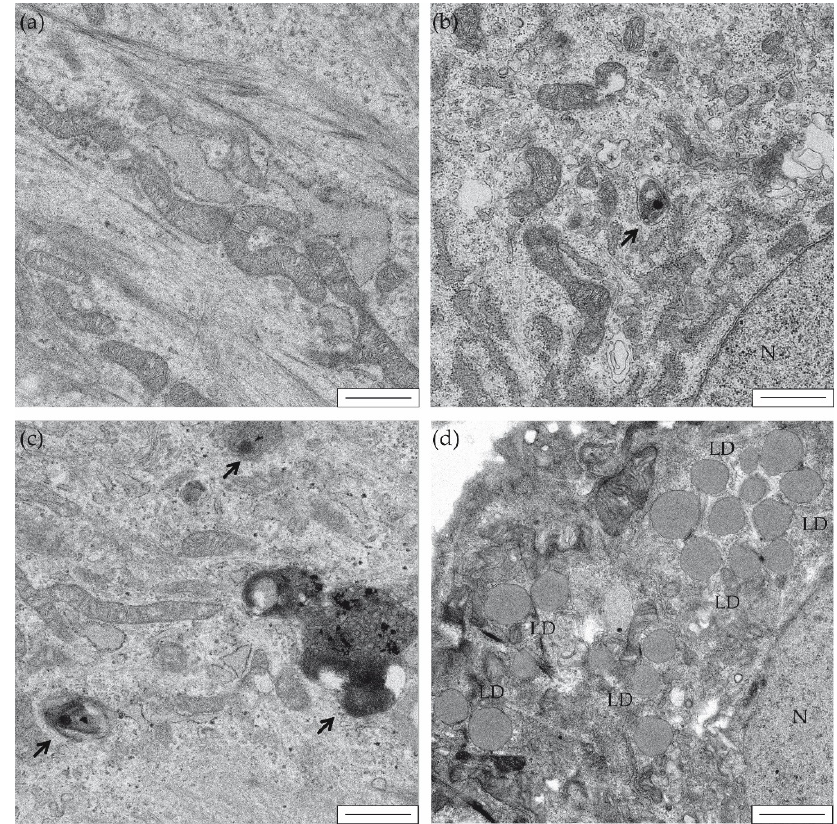
Figure 4. Electron microscopy of iPSC-derived cardiomyocytes. Representative images are shown of WT-iPSC-CMs ( a , b ) and PCCA iPSC-CMs ( c , d ) at 5000× magnification. Black arrows show degradation vesicles ( b , c ). LD: lipid droplets ( d ). N: cell nucleus ( b , d ). Scale bar: 1 µm.